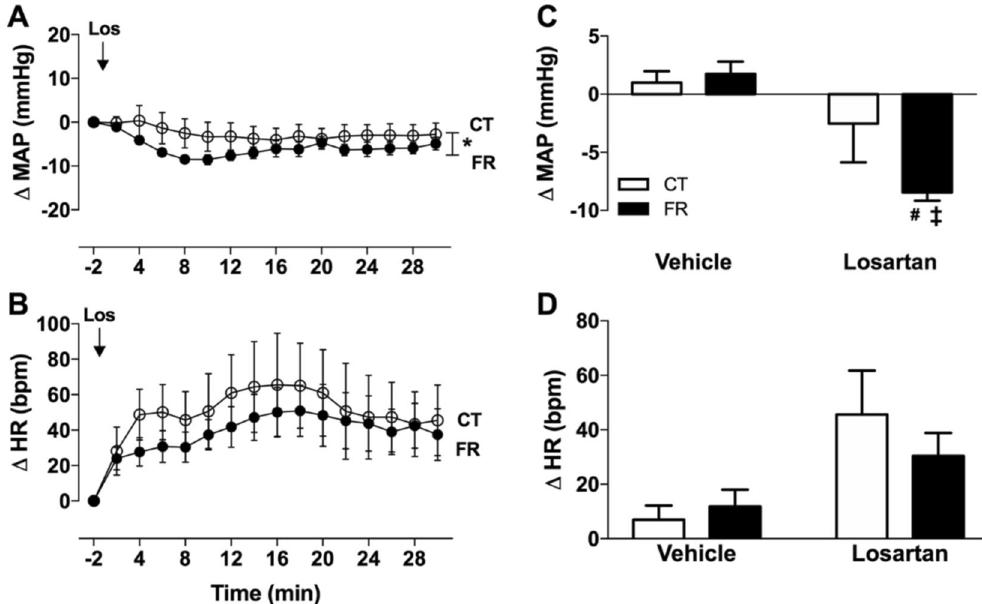
Figure 8. Effect of FR on MAP and HR responses to infusion of losartan. Shown are the changes ( A , B ) and maximum change from baseline ( C , D ) in MAP ( A , C ) and HR ( B , D ) after vehicle or losartan (Los) treatment in CT (open circle; white bar; n = 9) and FR (closed circle; black bar; n = 10) female rats. Basal MAP (mm Hg): CT, 122 ± 2 vs. * FR, 108 ± 1. Basal HR (bpm): CT, 374 ± 18 vs. FR, 365 ± 13. * P < 0.0001 vs. CT by two- way ANOVA and Bonferroni post-hoc test (time; diet); # P < 0.05 vs. vehicle, same animal group by unpaired Student’s t -test and ‡ p < 0.001 vs. CT, same treatment, by two-way ANOVA and Bonferroni post-hoc test (drug; diet); Values are expressed as the mean ± SEM.